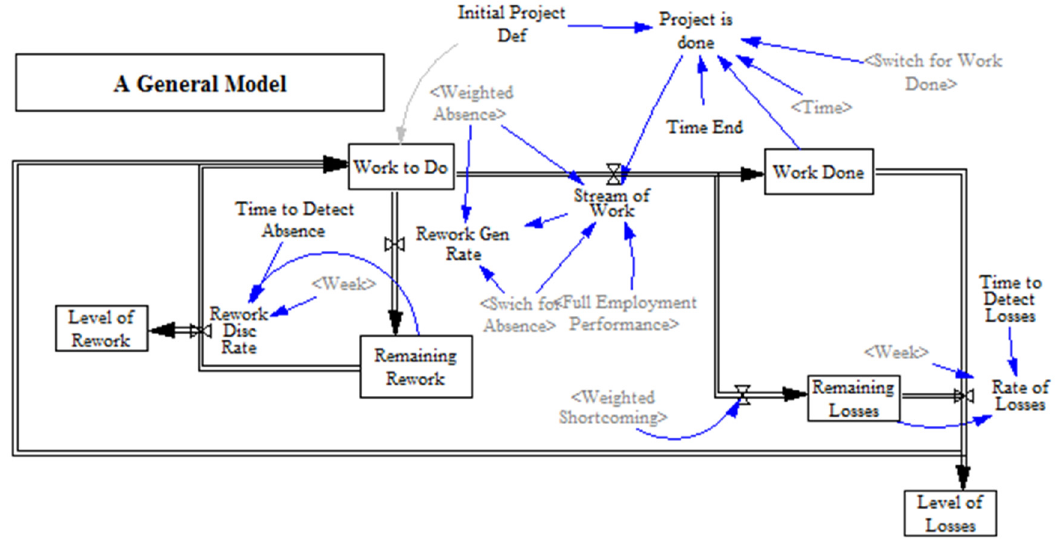
Figure 2. General Vensima simulation model for success criterion 𝐶 (cid:2869) : the number of well-conducted interviews according to the information available within the project realization